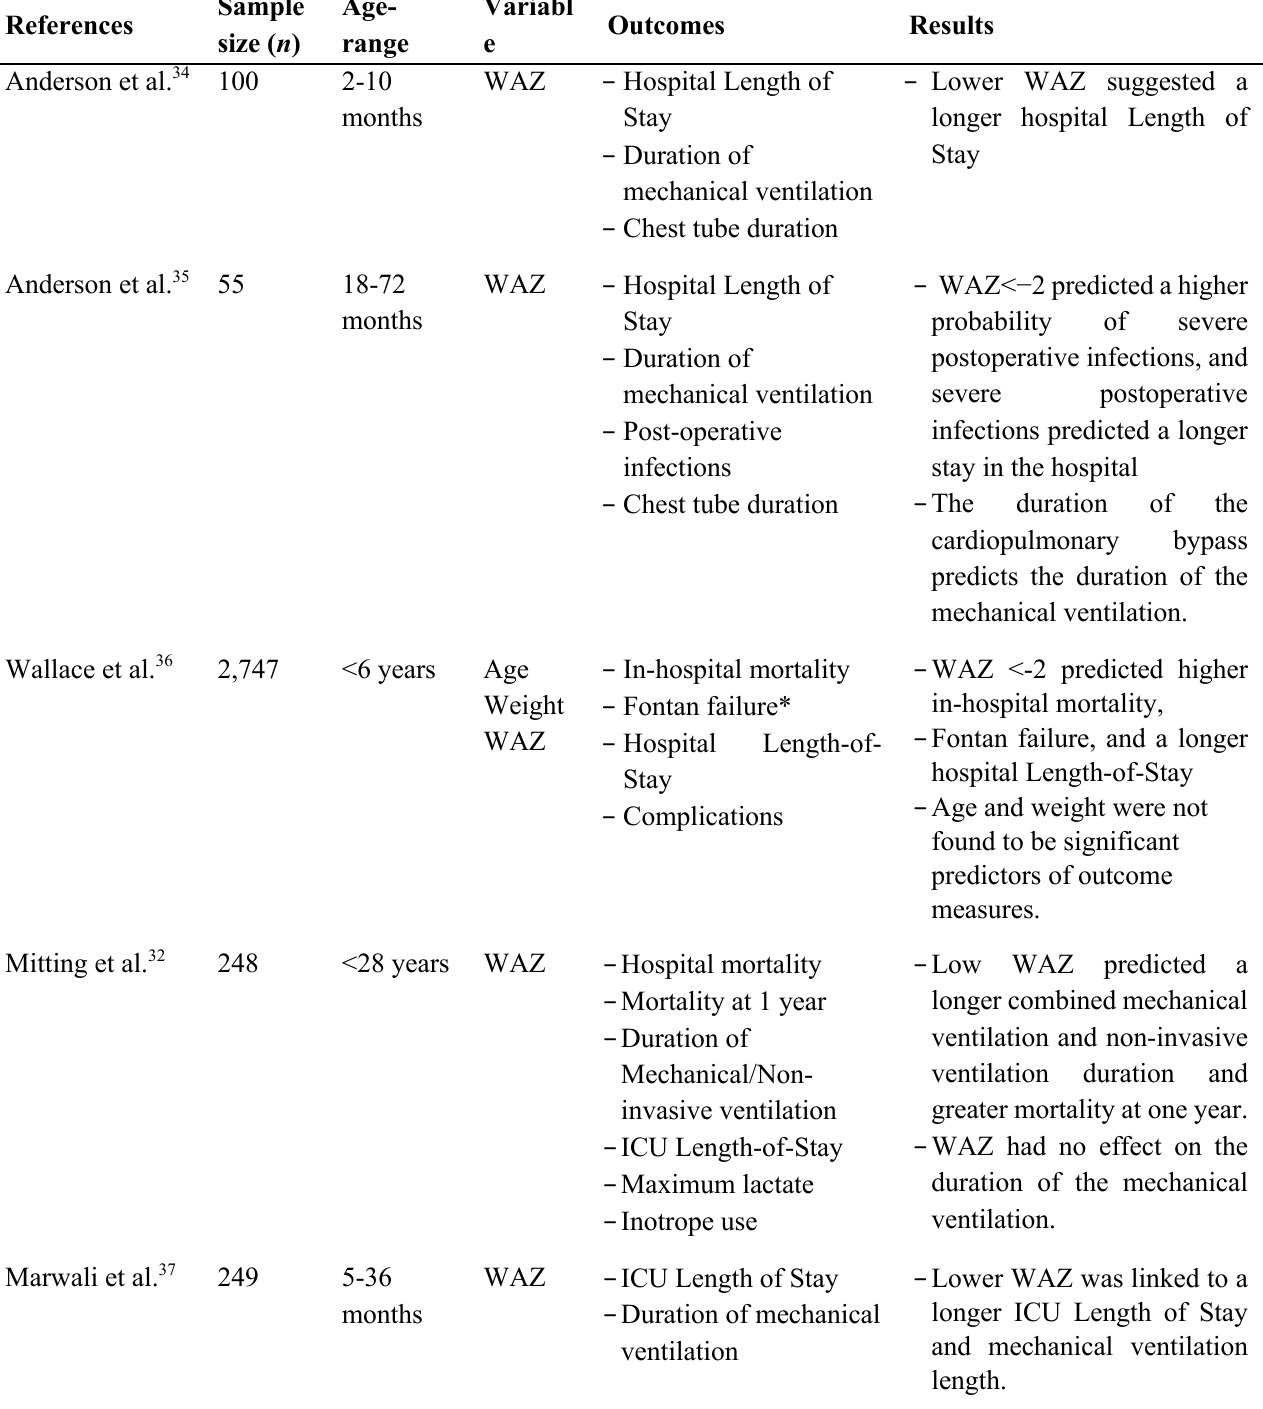
Tabel 1. Summary of the correlation between pre-operative nutritional status and post-operative